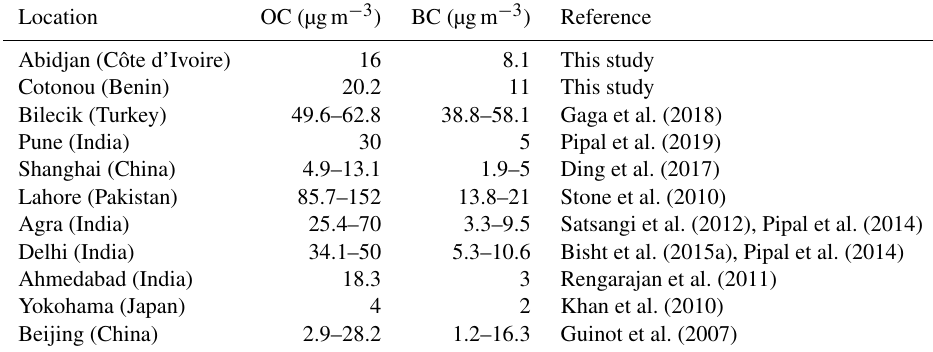
Table 6. EC and OC comparison with literature values. Only literature data given at a daily scale have been selected. Location